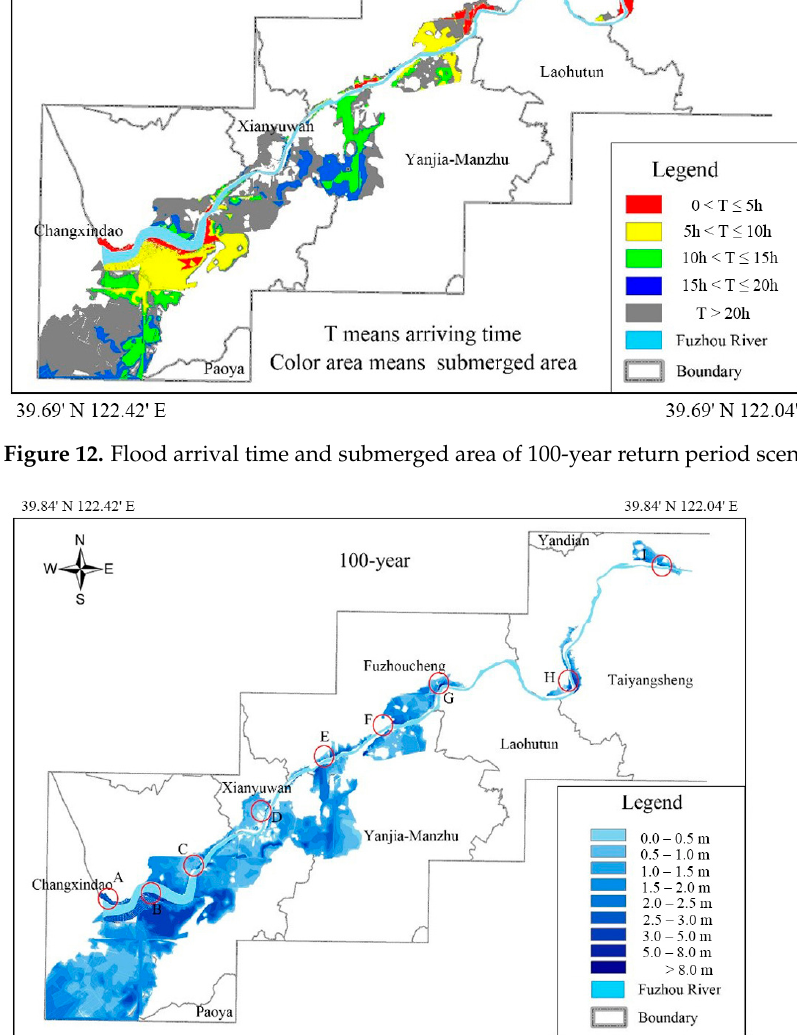
Figure 13. Submerged depth of 100-year return period scenario (Depth in here means maximum depth of the same point during the total flood process).